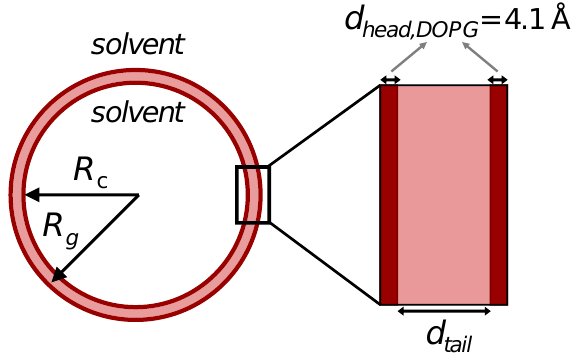
Figure 7. Schematic representation of a SUV structure and parameters obtainable from the CMS model. Different locations of radii obtained from different methods ( R c and R g ) are depicted. Moreover, size parameters describing the lipid membrane are